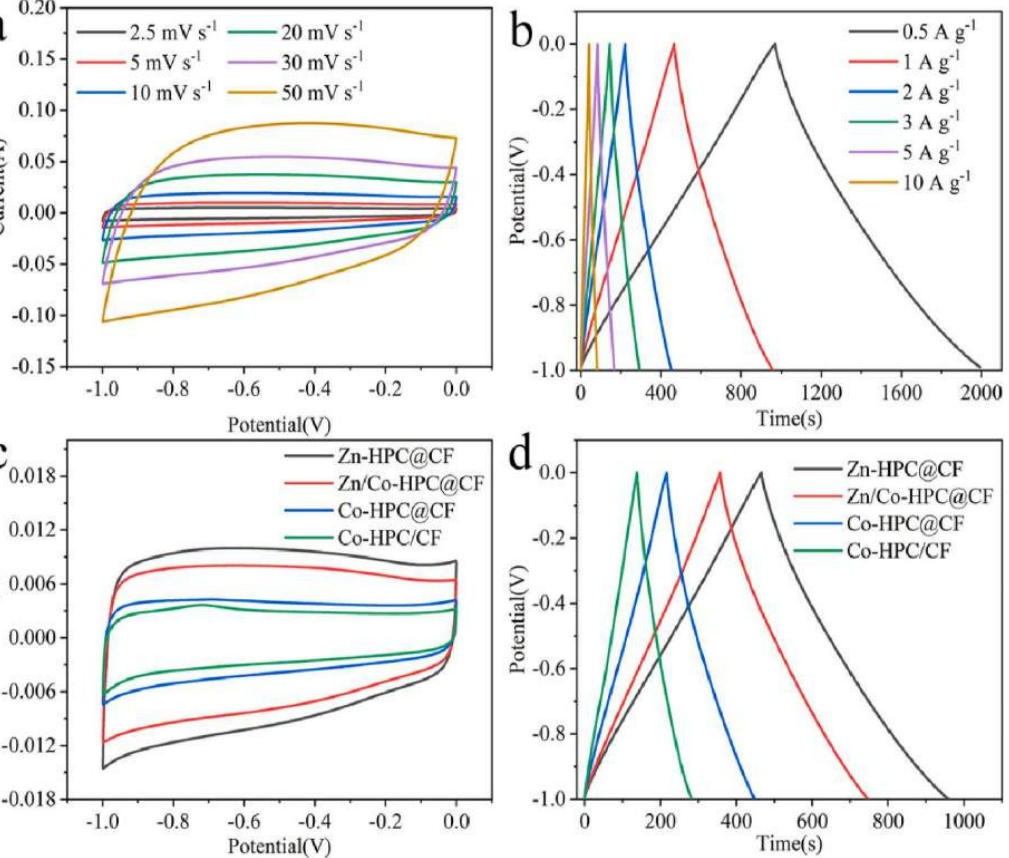
Figure 27. ( a ) CV curves at different scan rates and ( b ) GCD curves at different current densities of Zn-HPC@CF. ( c ) The CV curves at 2.5 mV s − 1 . ( d ) The GCD curves at 1 A g − 1 . Reproduced with permission from [108].